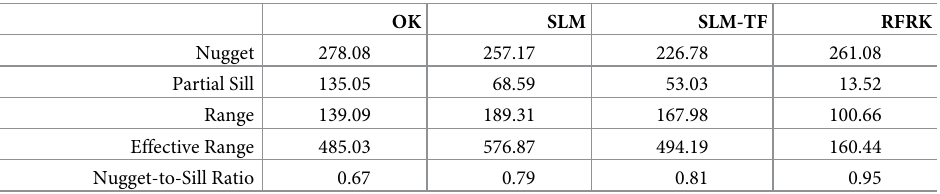
Table 2. Estimated covariance